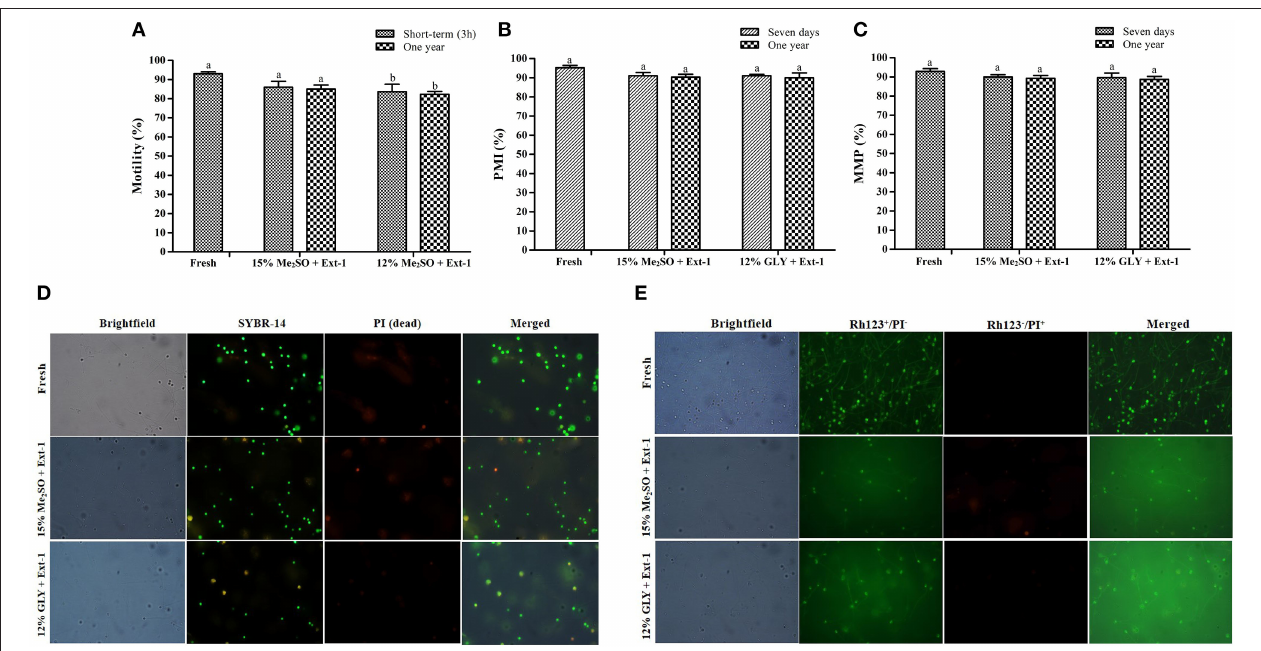
FIGURE 8 | Effects of 1-year cryopreservation on post-thaw sperm vitality of marbled flounder. (A) Post-thaw sperm motility of 1-year cryopreserved sperm ( n = 3); (B) plasma membrane integrity of 1-year cryopreserved sperm ( n = 3); (C) mitochondrial membrane potential of 1-year cryopreserved sperm ( n = 3); (D) fluorescent-stained photographs for detecting the plasma membrane integrity of 1-year cryopreserved marbled flounder sperm ( × 100 magnification). (E) Fluorescent-stained photographs for detecting the mitochondrial membrane potential of 1-year cryopreserved marbled flounder sperm ( × 100 magnification). Significant different levels ( p < 0.05) are denoted by different letters.